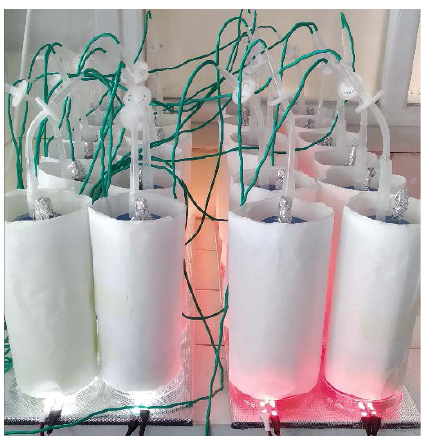
Figure A1. Experimental configuration for growing A. protethecoides with monochromatic illumi- nation by LEDs in 500 mL flasks aerated with sterilized air.